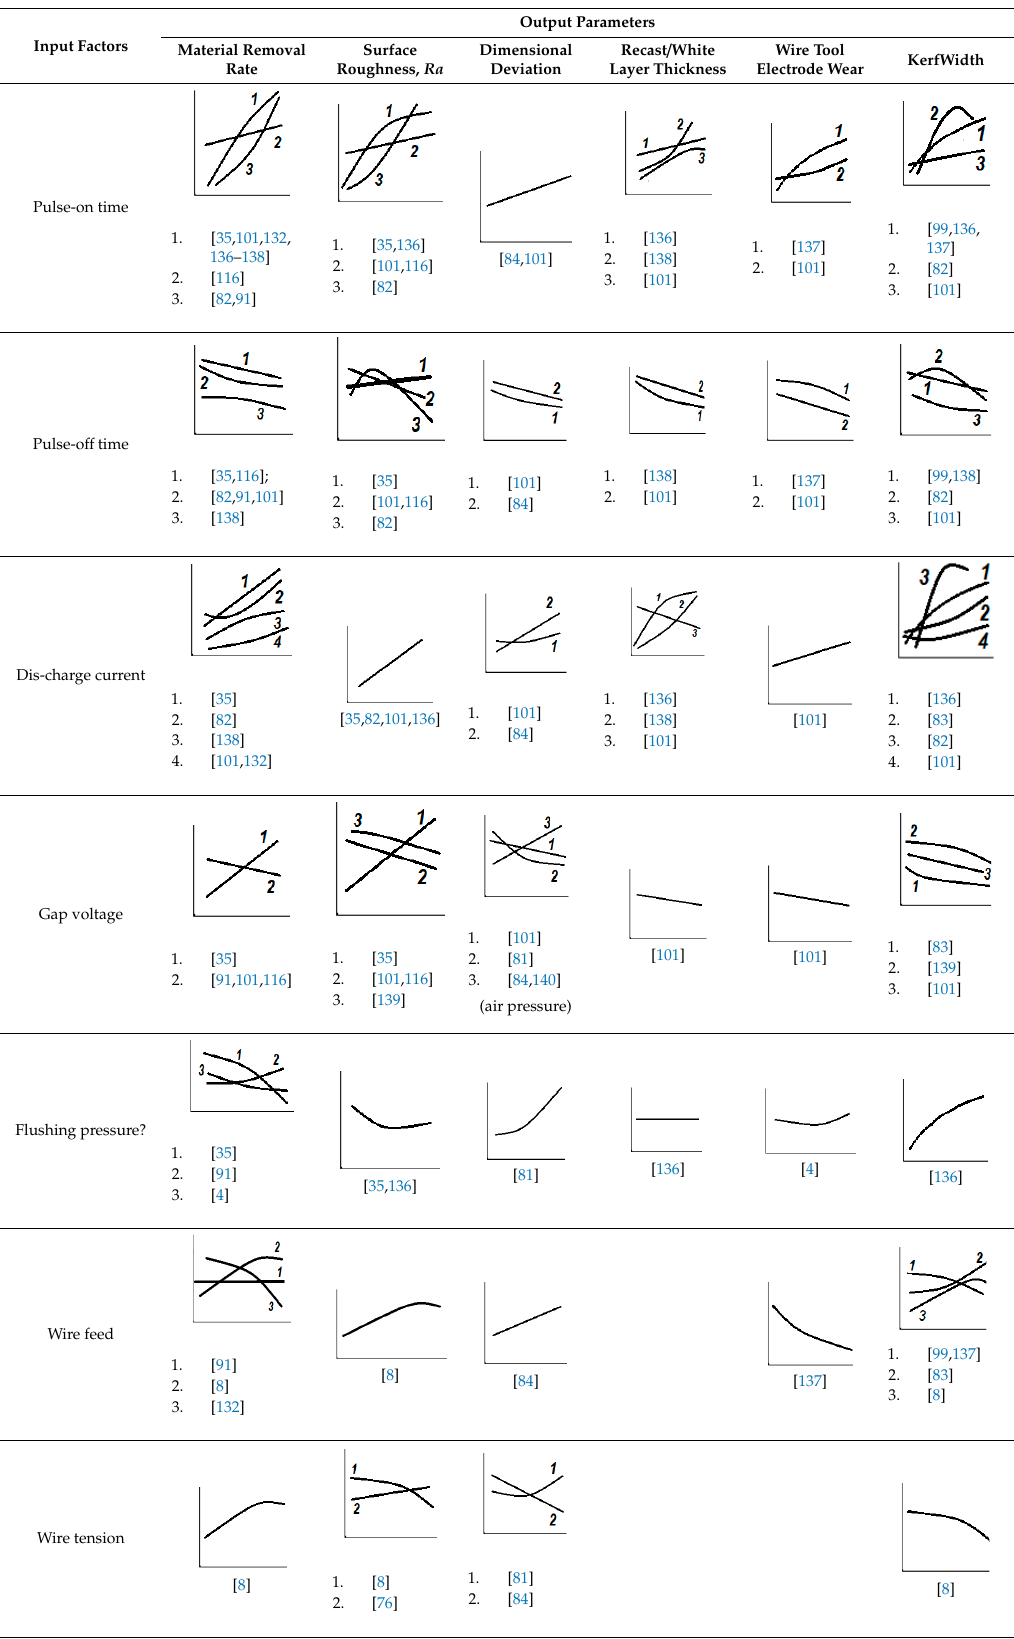
Table 1. E ff ects exerted by distinct input factors on the values of the output parameters in the case Table 1. Effects exerted by distinct input factors on the values of the output parameters in the case of Table 1. Effects exerted by distinct input factors on the values of the output parameters in the case of Table 1. Effects exerted by distinct input factors on the values of the output parameters in the case of Table 1. Effects exerted by distinct input factors on the values of the output parameters in the case of Table 1. Effects exerted by distinct input factors on the values of the output parameters in the case of WEDM. Table 1. Effects exerted by distinct input factors on the values of the output parameters in the case of WEDM. WEDM. of WEDM. WEDM. WEDM. Table 1. Effects exerted by distinct input factors on the values of the output parameters in the case of Table 1. Effects exerted by distinct input factors on the values of the output parameters in the case of WEDM. Table 1. Effects exerted by distinct input factors on the values of the output parameters in the case of Table 1. Effects exerted by distinct input factors on the values of the output parameters in the case of Table 1. Effects exerted by distinct input factors on the values of the output parameters in the case of Table 1. Effects exerted by distinct input factors on the values of the output parameters in the case of WEDM. WEDM. WEDM. WEDM. WEDM. WEDM. Table 1. Effects exerted by distinct input factors on the values of the output parameters in the case of Table 1. Effects exerted by distinct input factors on the values of the output parameters in the case of Table 1. Effects exerted by distinct input factors on the values of the output parameters in the case of Table 1. Effects exerted by distinct input factors on the values of the output parameters in the case of WEDM. WEDM. Table 1. Effects exerted by distinct input factors on the values of the output parameters in the case of WEDM. Table 1. Effects exerted by distinct input factors on the values of the output parameters in the case of WEDM. WEDM.